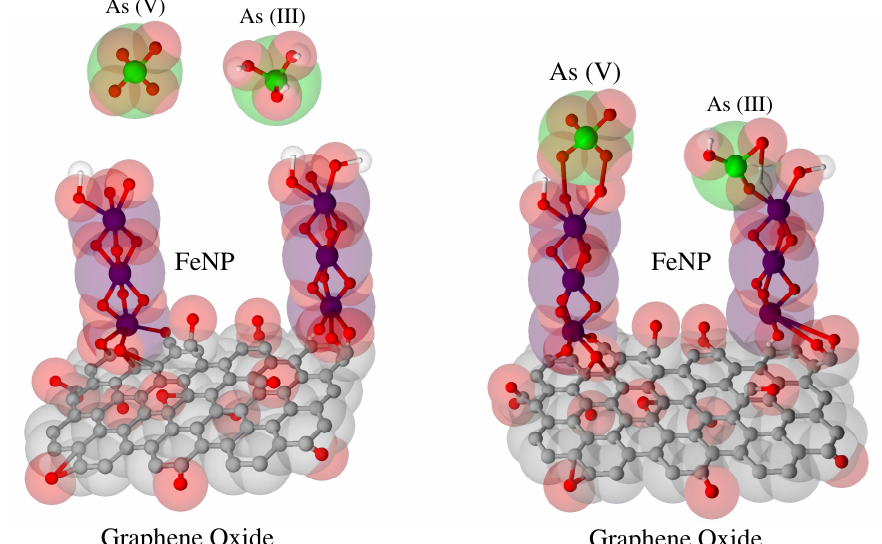
Figure 2. Possible mechanism of arsenic adsorption on FeNP@GO (figure adapted from Das et al., (2020) [62]). This proposed mechanism involves arsenic flux built up at the solution–adsorbent interface, which is followed by adsorption onto the iron nanoparticles (FeNPs) present on